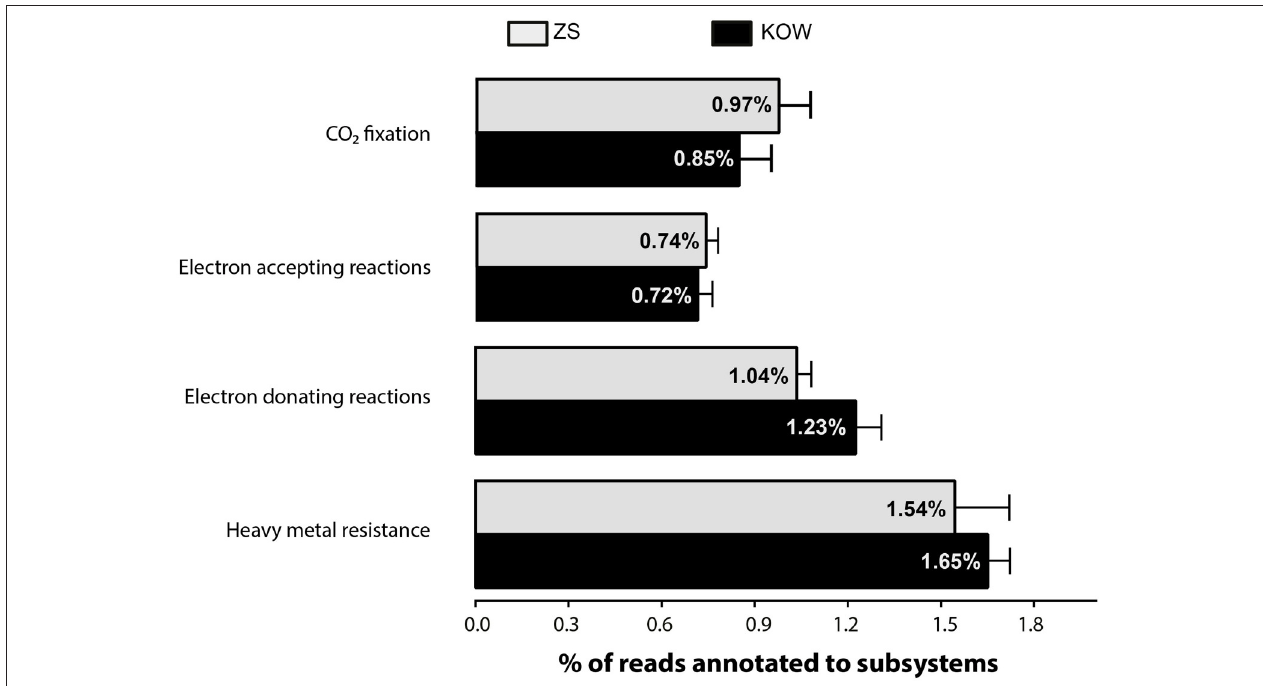
FIGURE 5 | Abundance of subsystems involved in heavy metal homeostasis among all subsystem-annotated metagenomic reads. Heavy metal resistance includes the following subsystems: arsenic resistance, resistance to chromium compounds, zinc resistance, cadmium resistance, cobalt-zinc-cadmium resistance, copper homeostasis, mercuric reductase, mercuric resistance operon, and tellurite resistance: chromosomal determinants.